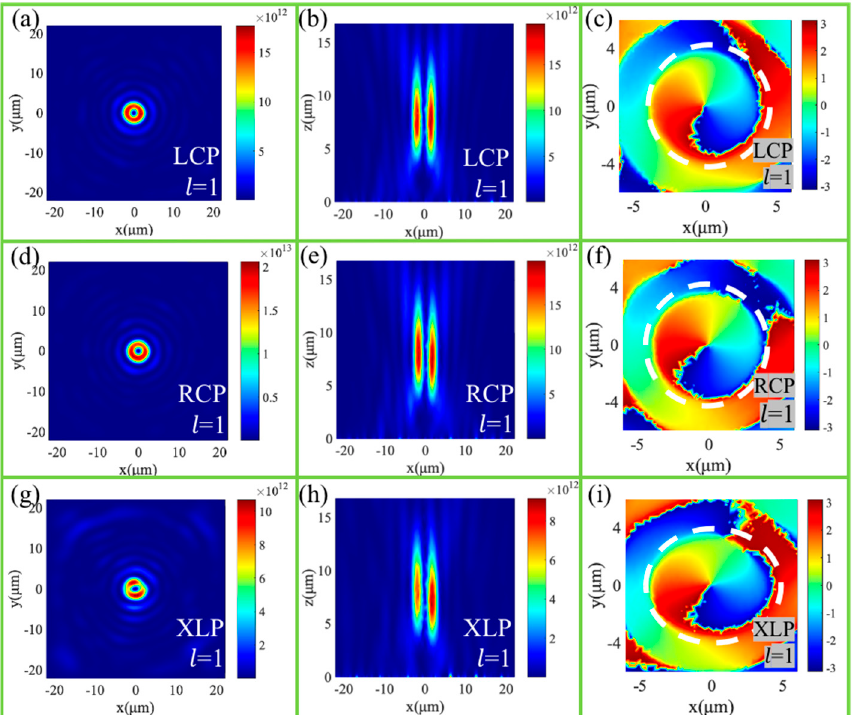
Figure 5. The intensity distributions of the vortex beam at the focusing plane under the LCP ( a ), RCP ( d ) and XLP ( g ) light illuminations. The intensity distributions of the converged vortex beam at the x-z plane under the LCP ( b ), RCP ( e ) and XLP ( h ) light illuminations. The phase distributions of the vortex beam at the focusing plane under the LCP ( c ), RCP ( f ) and XLP ( i ) light